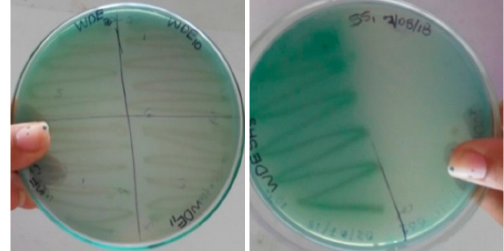
Fig. 1. Enriched isolates grow on Malachite Green agar, selective for Pseudomonas Table 2. Bacterial load of PRE from refinery industry